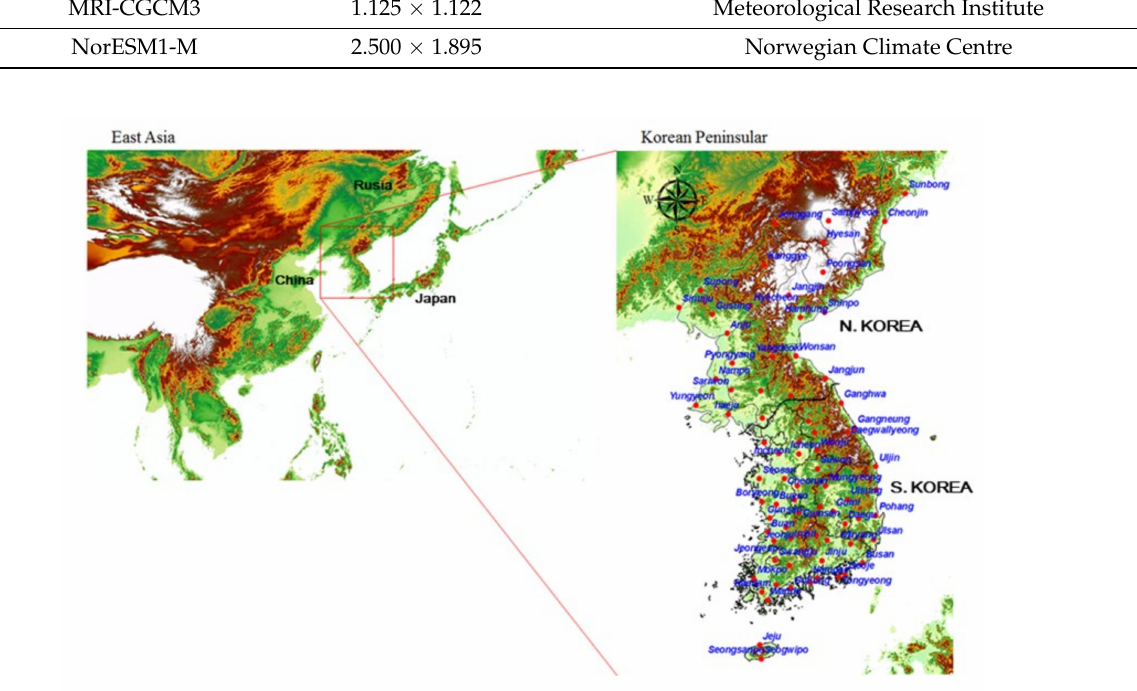
Figure 2. Meteorological Station in Republic of